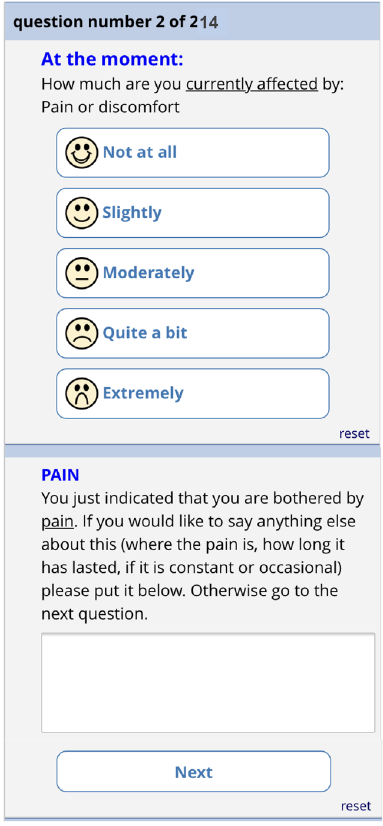
Figure 12. Pre-consultation form: Pain question.